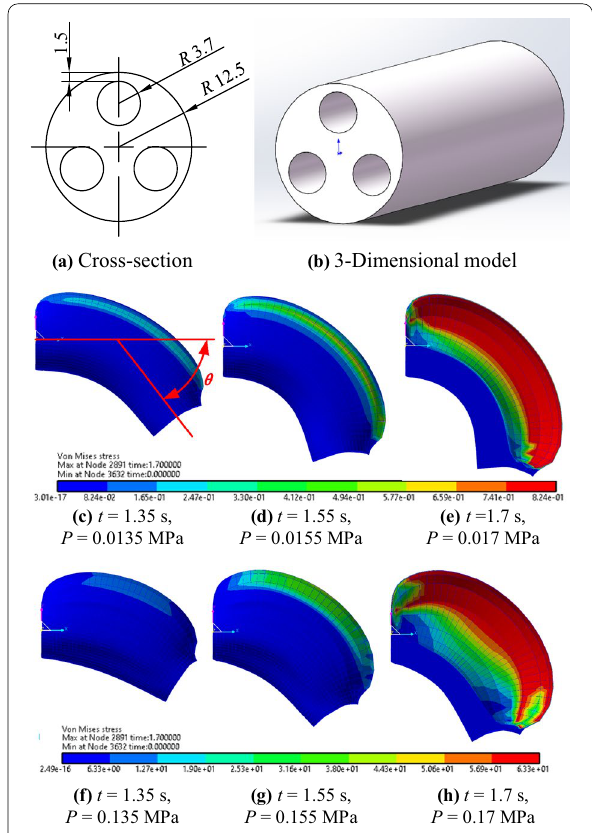
Figure 4 3-Dimensional model of circular cross-section and the simulation